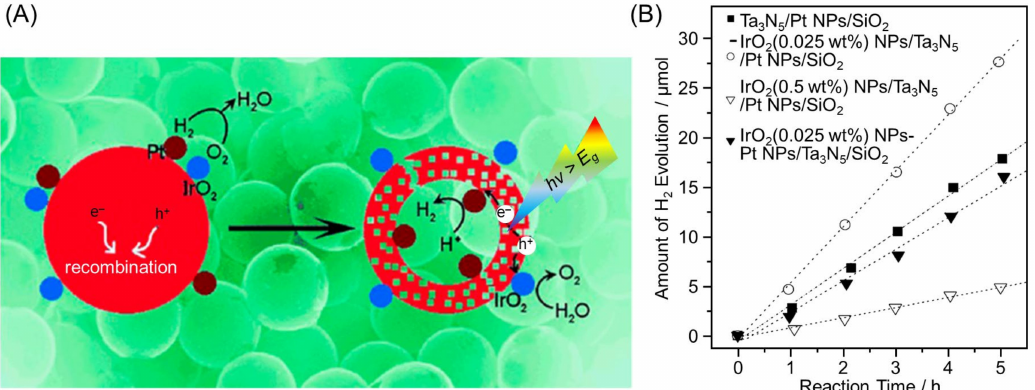
Figure 38. ( A ) Design principle for a yolk–shell Ta 3 N 5 photocatalyst loaded with two separate cocatalysts as effective charge collectors for water splitting. ( B ) H 2 -evolution activities on yolk–shell Ta 3 N 5 photocatalysts with separated and mixed Pt NPs and IrO 2 NPs cocatalysts. Reaction conditions: Ta 3 N 5 catalyst, 0.032 g; methanol, 20 mL; H 2 O, 80 mL; 300 W Xe lamp with an L42 cutoff filter; top irradiation. Reproduced with permission from reference [291]. Copyright 2013 Wiley-VCH.